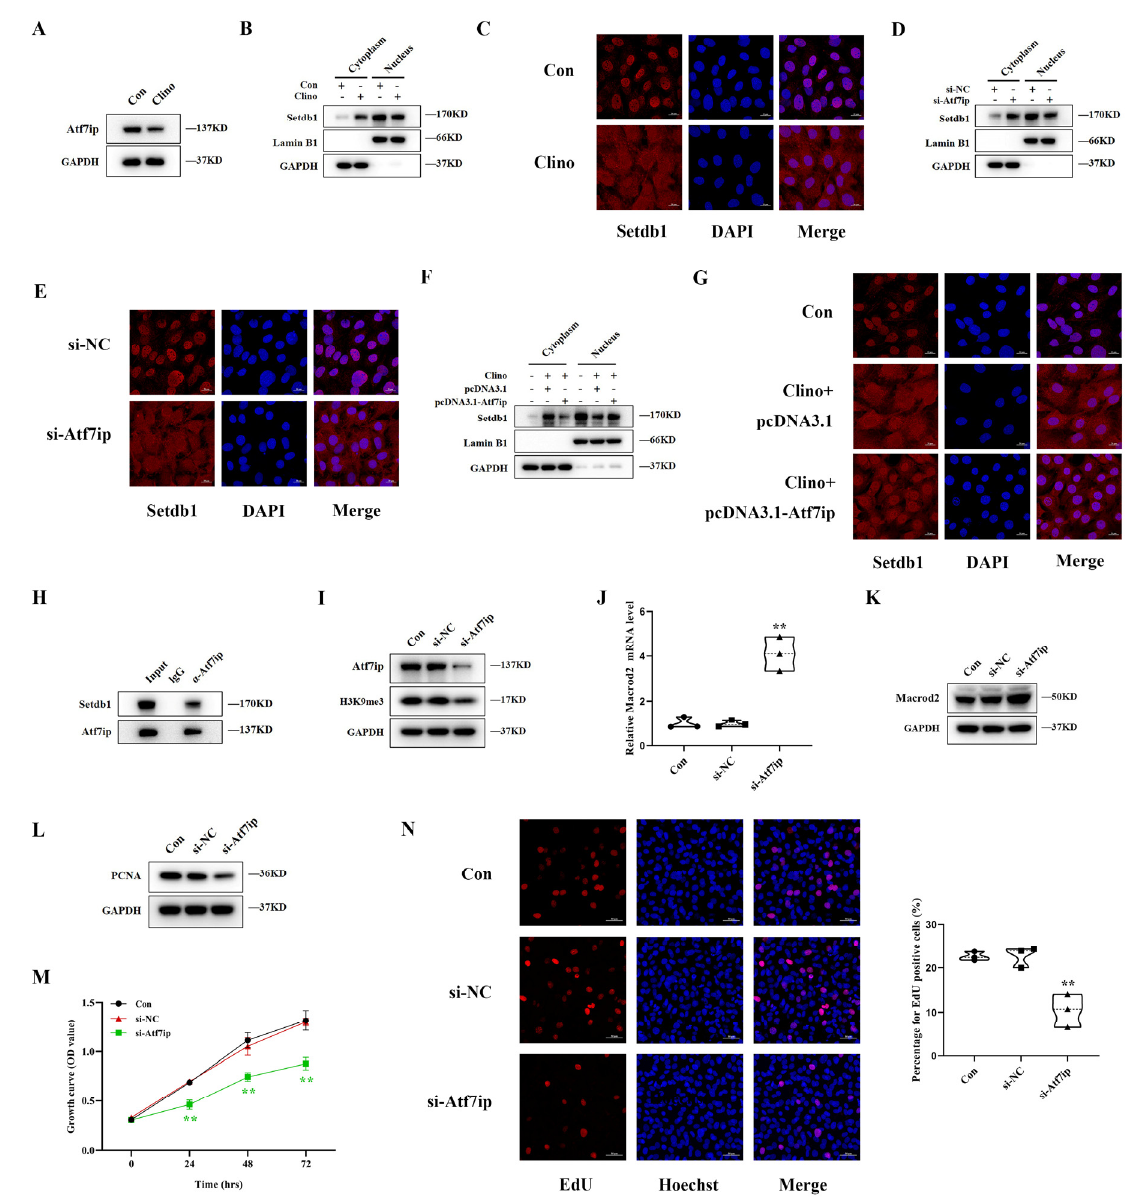
Figure 7. Atf7ip regulates the nuclear localization of Setdb1 and exhibits a similar effect on osteoblast proliferation under mechanical unloading. ( A ) Western blotting analysis of the Atf7ip protein level in 48 h under clinorotation unloading ( n = 3). ( B ) Setdb1 expression in the nucleus and cytoplasm of MC3T3-E1 cells by Western blotting under clinorotation unloading for 48 h ( n = 3). ( C ) The localization of Setdb1 examined by immunofluorescence staining ( n = 3). Scale bar, 20 µ m. ( D ) The protein level of Setdb1 in the nucleus and cytoplasm in MC3T3-E1 cells transfected by si-Atf7ip or its negative control by Western blotting ( n = 3). ( E ) The localization of Setdb1 examined by immunofluorescence staining in MC3T3-E1 cells transfected by si-Atf7ip or its negative control ( n = 3). Scale bar, 20 µ m. ( F )Western blotting analysis of Setdb1 in the nucleus and cytoplasm in MC3T3-E1 cells after treatment with pcDNA3.1-Atf7ip, or its negative control under clinorotation unloading for 48 h ( n = 3). ( G ) Immunofluorescence staining showing the location of Setdb1 ( n = 3). ( H ) The association between Atf7ip with Setdb1 was validated by Co-IP through anti-Atf7ip ( n = 3). ( I ) The protein expression of Atf7ip and H3K9me3 in MC3T3-E1 cells transfected by si-Atf7ip and its negative control by Western blotting ( n = 3). ( J ) qRT-PCR analysis of Macrod2 mRNA level in MC3T3-E1 cells transfected with si-Atf7ip, or the corresponding control ( n = 3). One-way ANOVA followed by LSD’s multiple comparisons test. ( K ) Macrod2 protein expression by Western blotting ( n = 3). ( L )